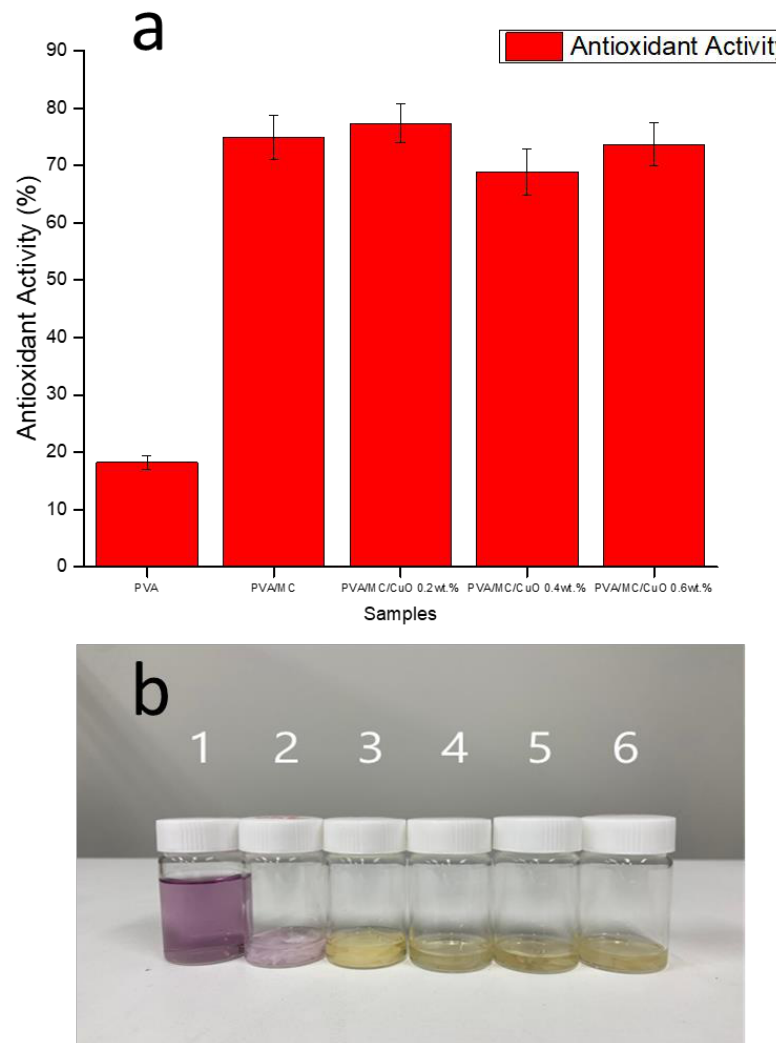
Figure 6. ( a ) DPPH free radical scavenging activity of PVA/MC/CuO 0.2 wt.%, PVA/MC/CuO 0.4 wt.%, and PVA/MC/CuO 0.6 wt.%. ( b ) Color appearances of 1 — DPPH free radical scavenging activity, 2 — PVA, 3 — PVA/MC, 4 — PVA/MC/CuO 0.2 wt.%, 5 — PVA/MC/CuO 0.4 wt.%, 6 — PVA/MC/CuO 0.6 wt.% .